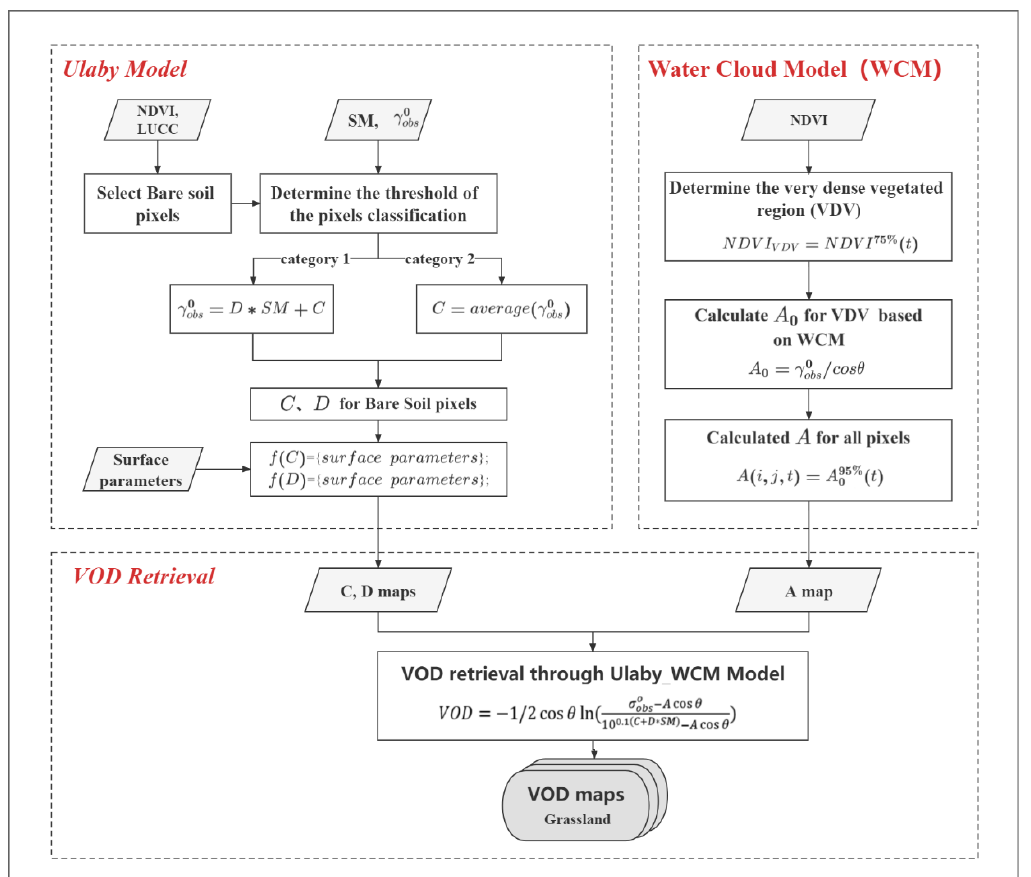
Figure 2. Flowchart of VOD retrieval based on a combination of the WCM and Ulaby models.